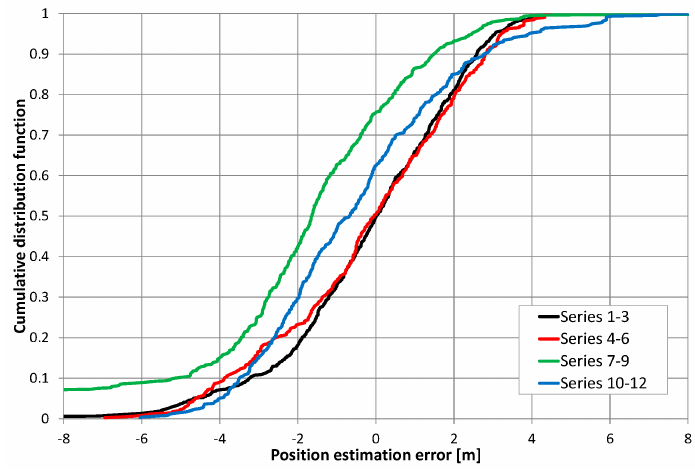
Figure 15. Cumulative distribution of position estimation